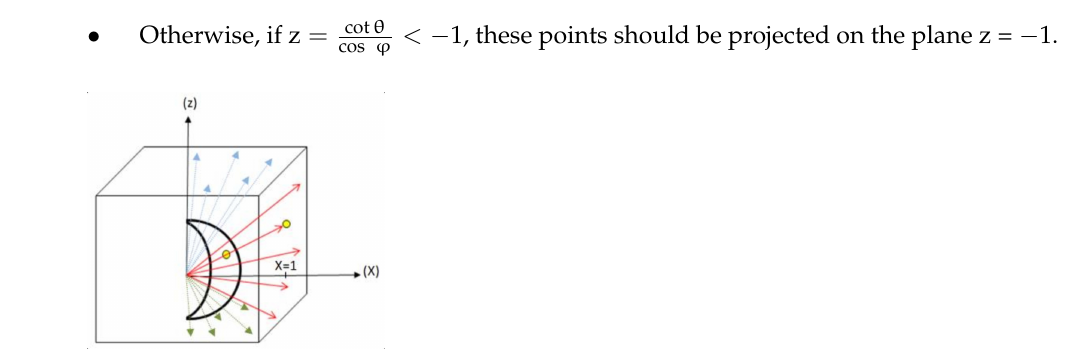
Figure 8. Projection of the 1st region of the sphere onto the 1st lateral facet of the cube and the two upper and lower facets after applying the condition on coordinate z.